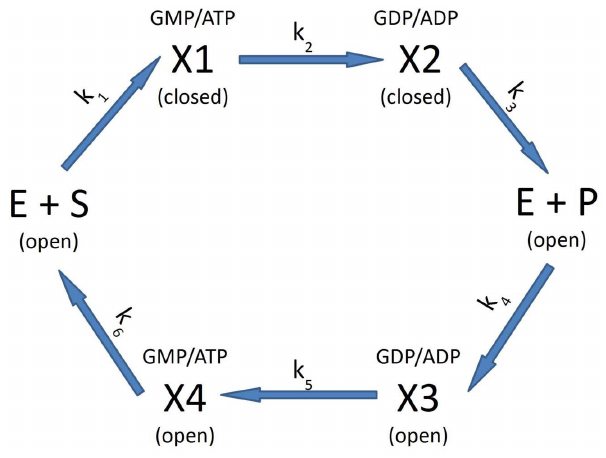
Figure 5. A proposed two-dimensional reaction scheme which can explain the observed effects of mechanical stress. E, S, and P stand for enzyme, substrates, and products; the upper branch refers to the forward reaction, the lower branch to the reverse reaction. Open and closed refer to the state of the enzyme; X 1 is a complex of the enzyme with GMP and ATP, and similarly for the other